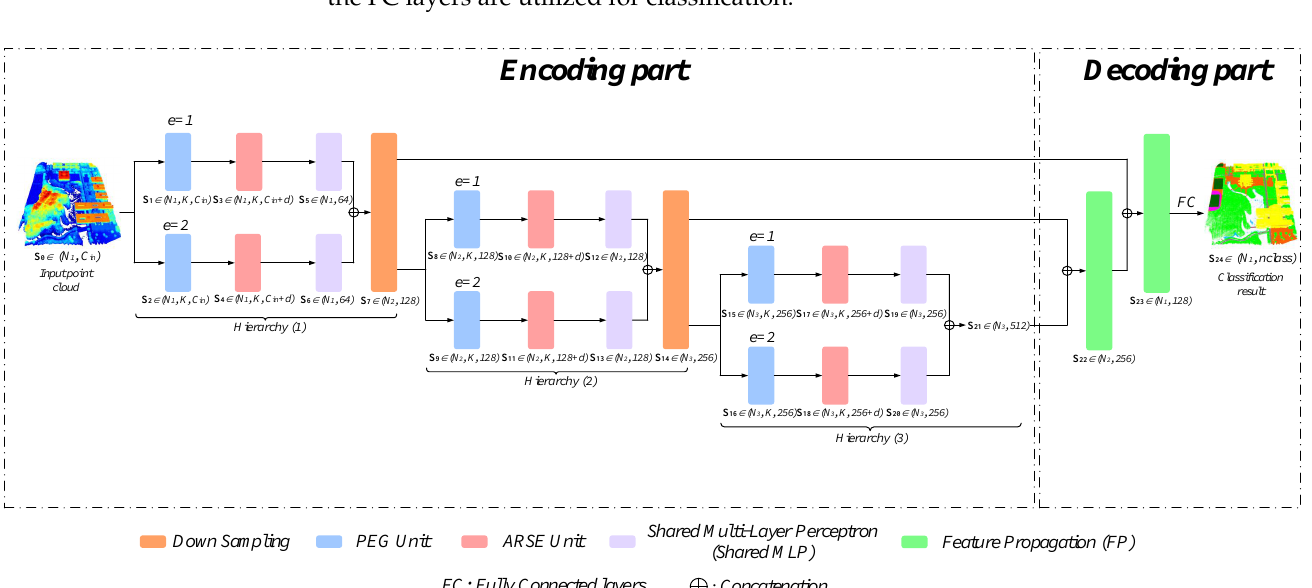
Figure 1. Illustration of the detailed architecture of PEMCNet for large-scale point cloud classification. The encoding part is composed of PEG unit, ARSE unit and Shared MLP. The decoding components mainly consist of FP. S i ( i = 1,2, . . . ,24 ) represents the obtained feature vectors of each function